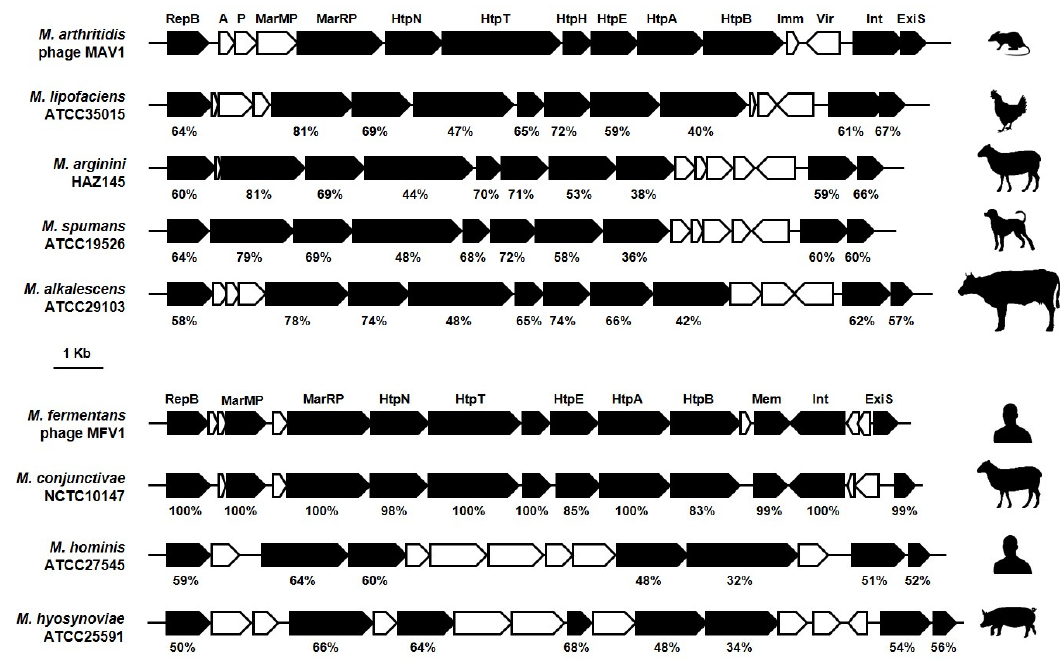
Figure 4. Comparison of ϕ MAV1 and ϕ MFV1 genomic regions with prophage sequences identified in mycoplasma species of the Hominis phylogenetic group. ϕ MAV1-like and ϕ MFV1-like sequences were identified by BLASTP analyses using CDSs highlighted in black and a sequence database consisting of non-redundant protein sequences restricted to Mollicutes (taxid:31969). No similarity was identified outside of the Hominis phylogenetic group. CDS products in ϕ MAV1 and ϕ MFV1 are indicated. For each CDS, the percentage of global similarity with ϕ MAV1 or ϕ MFV1 is indicated. This value was determined by using the EMBOSS Needle alignment tool. Animal icons are used to illustrate the host tropism of each strain. These illustrations are limited to a single prophage sequence per chromosome, and a single strain per species. The overall organization ϕ MAV1 is highly conserved among ϕ MAV1-like sequences, which mainly di ff er at putative repressor ( imm ) and virulence ( vir ) genes and CDSs located at close proximity. A remarkable feature of ϕ MFV1 genomic region is its proximity with the animal Mycoplasma species M. conjunctivae .